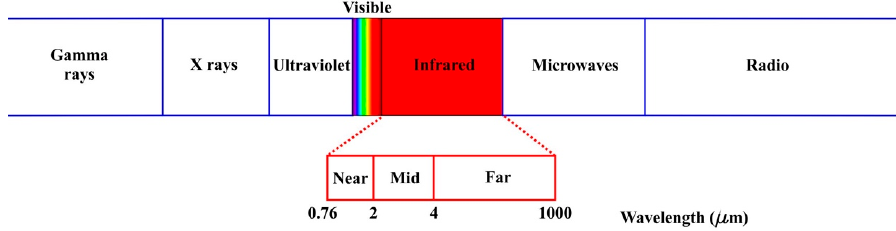
Figure 7. Electromagnetic spectrum.